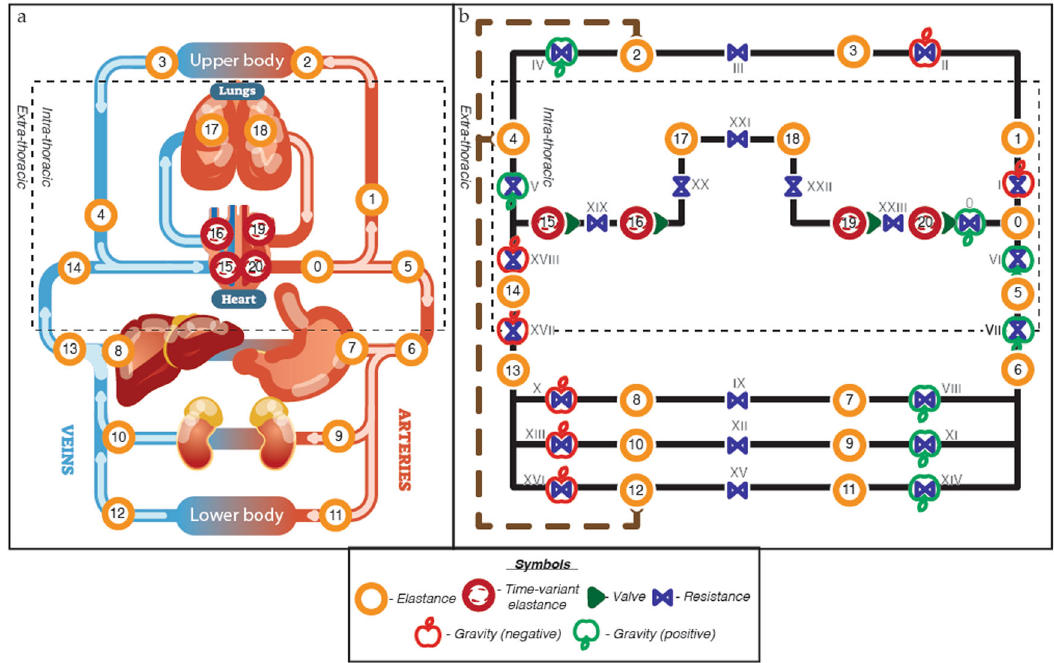
Fig. 3 Diagram and conceptual model of the 21-compartment cardiovascular model. 0: Ascending aorta. 1: Brachiocephalic arteries. 2: Upperbody arteries. 3: Upper body veins. 4: Superior vena cava. 5: Thoracic aorta. 6: Abdominal aorta. 7: Renal arteries. 8: Renal veins. 9: Splanchnic arteries. 10: Splanchnic veins. 11: Lower body arteries. 12: Lower body veins. 13: Abdominalveins. 14: Thoracic inferior vena cava. 15: Right atrium. 16: Right ventricle. 17: Pulmonary arteries. 18: Pulmonary veins. 19: Left atrium. 20: Left ventricle. a Anatomic model. Dashed square indicated the intrathoracic pressure. b Hydraulic circuit model. The orange circles with numbers are elastic elements with a pre and post resistance in blue and annotated with Roman numbers. The cardiac compartments are illustrated with red circles and represent time- variant elastances, together with their valves (green single triangles). The dashed rectangle outlines the intrathoracic compartments, and the brown wide-dashed line with round arrowheads indicates the lymphatic fl ow from the lower and upper body to the super vena cava. The green and red apple indicate gravity and its direction (green = added, red = subtracted) 18,39